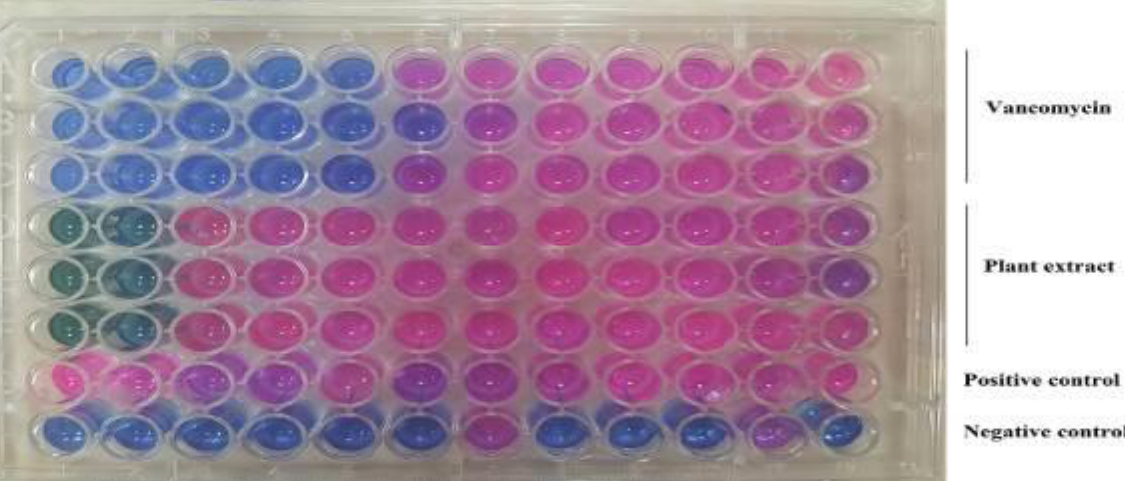
Figure. 1. Determination of MIC for Vancomycin and Scrophularia striata against methicillin resistance Staphylococcus aureus (ATCC 33591).